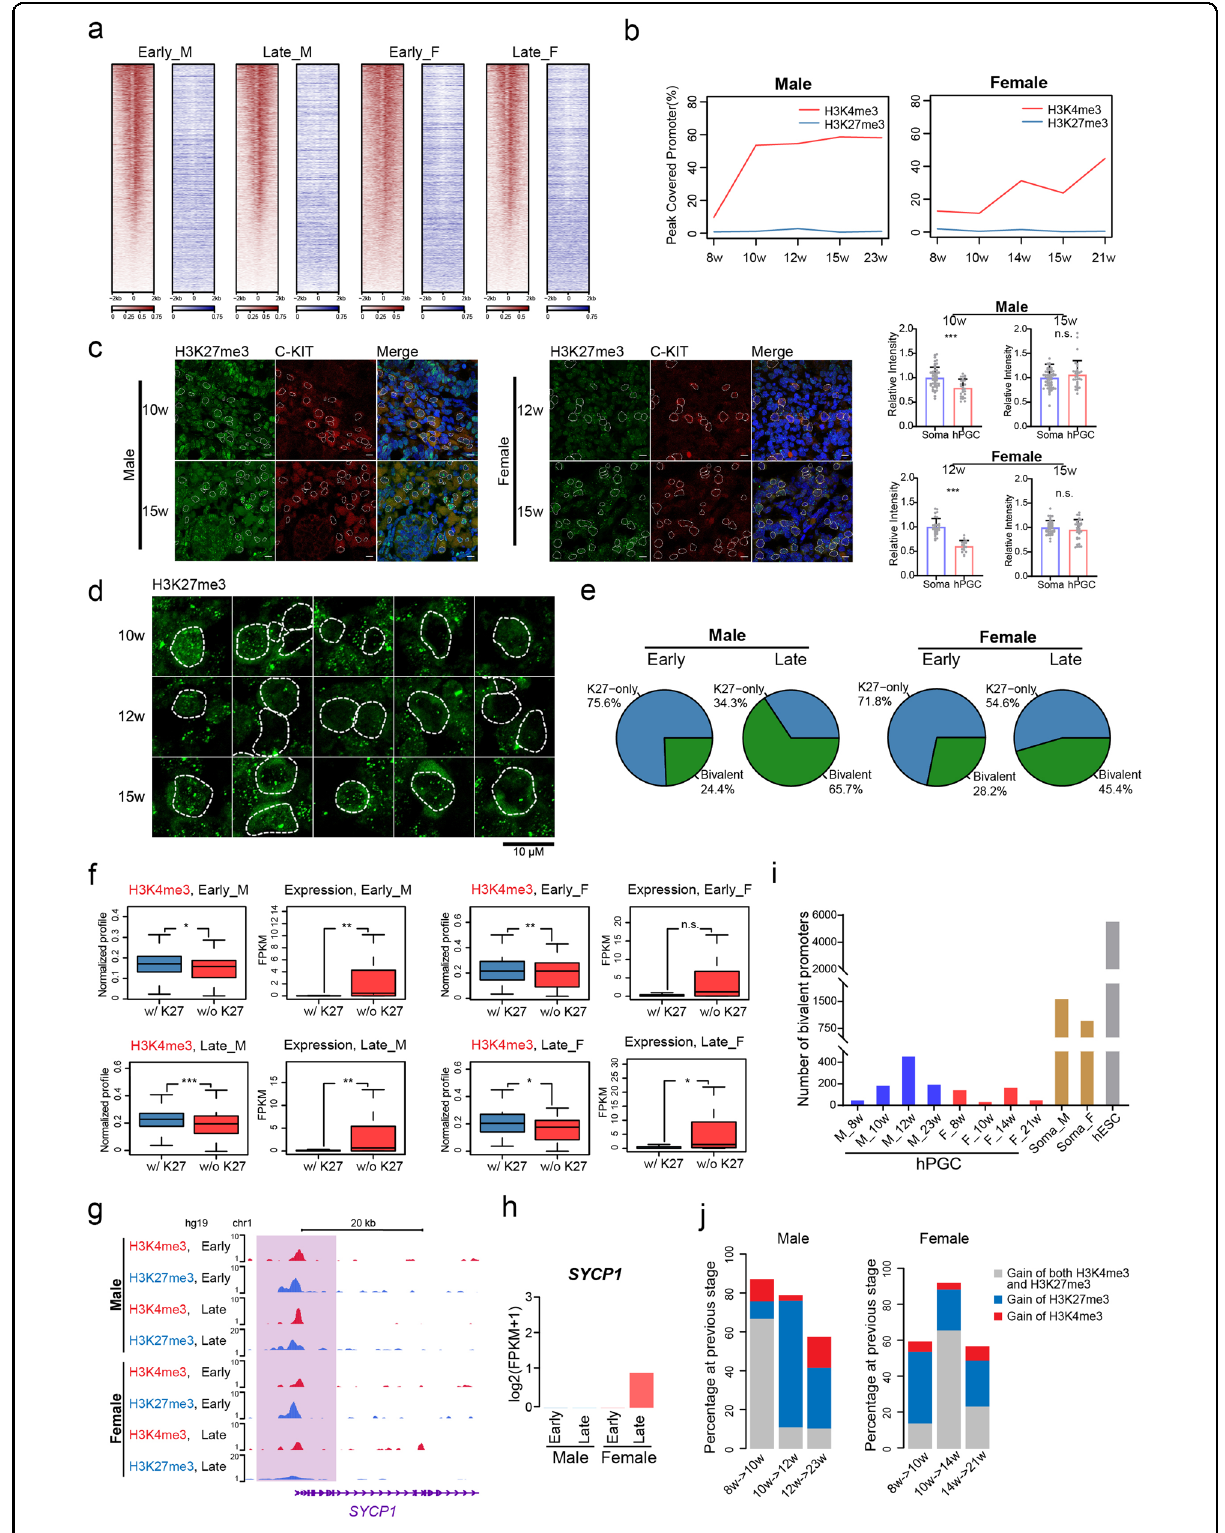
Fig. 2 (See legend on next